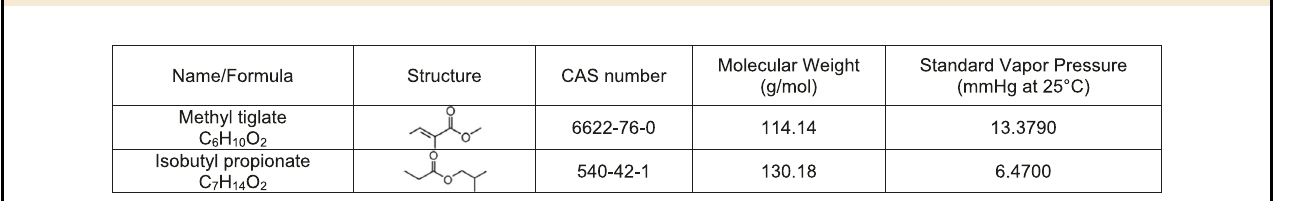
Table 1 Odor information related to Figs. 2, 4 and